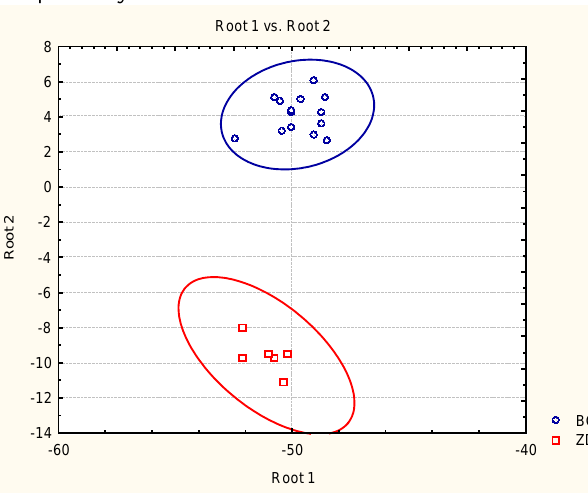
Fig. 3. Results of discriminatory analysis applied to E-tongue data. 2D distribution of patterns in the plane of the first and second canonical roots. The data dimensionality reduction technique is Fourier Transform. M =